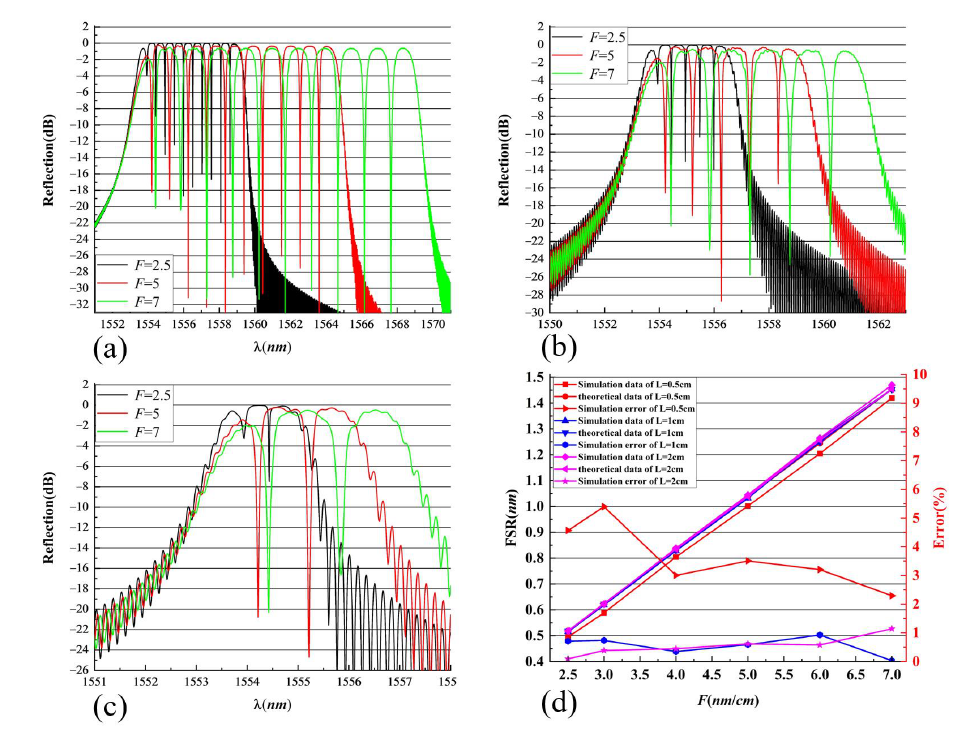
Figure 4. Simulation results for different chirp coefficients and grating lengths. ( a ) Spectra for different chirp coefficients when L = 0.5 cm. ( b ) Spectra for different chirp coefficients when L = 1 cm. ( c ) Different chirp coefficients when L = 2 cm. ( d ) FSR vs. chirp coefficient variation curve and simulation